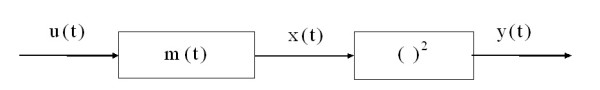
ME channel model for single motor unit. u(t) is the innervation process from MN, m(t) is the impulse response function of motor unit, and ( )2 is the nonlinear processor with square operator [7].